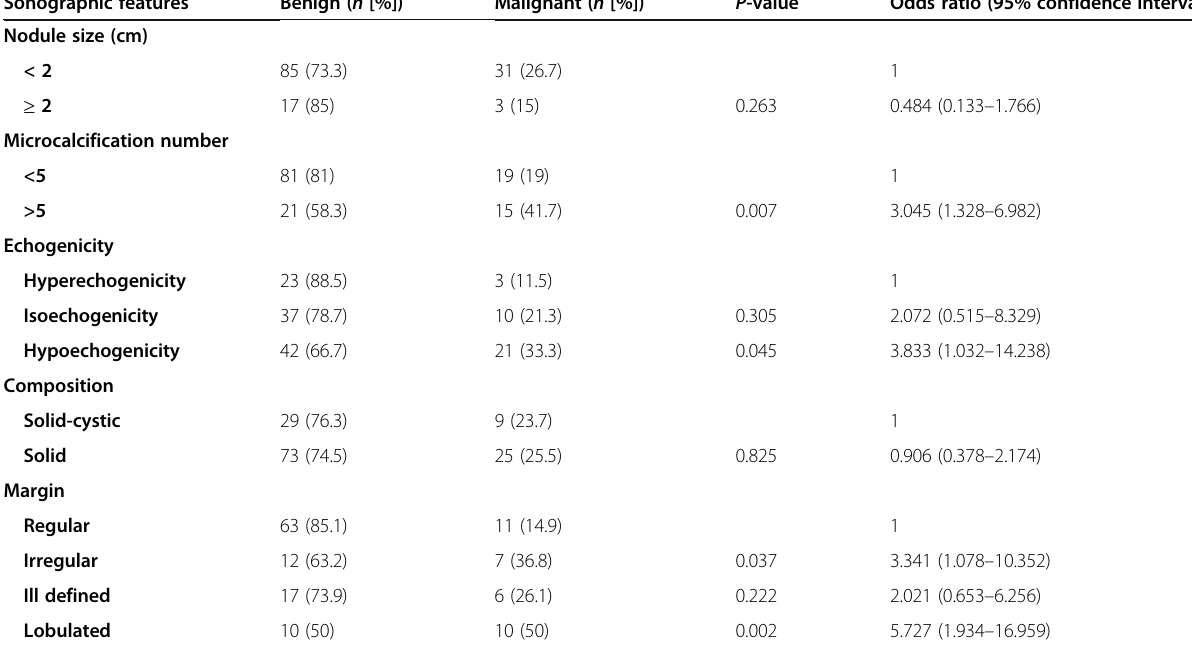
Table 2 Association between sonographic characteristics and cytology results of the thyroid nodules with microcalcification Sonographic features